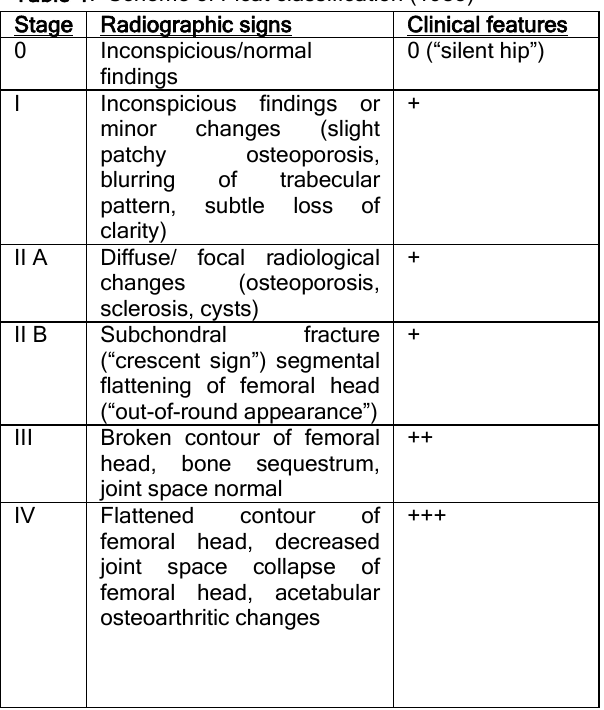
Table 1: Scheme of Ficat classification (1985)